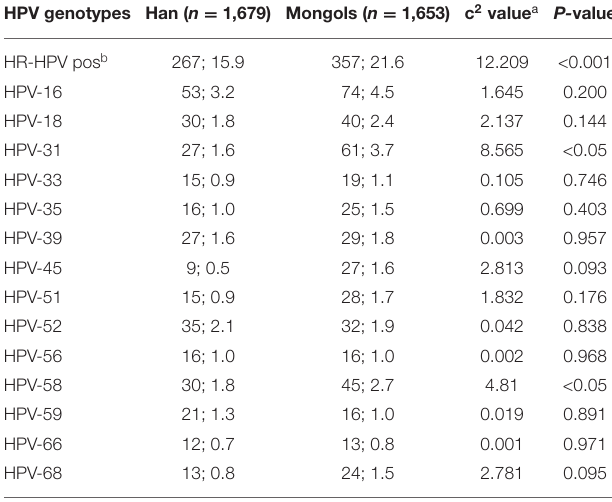
TABLE 1 | The prevalence and type-specific distribution of hr-HPV between Han and Mongols women ( n ;